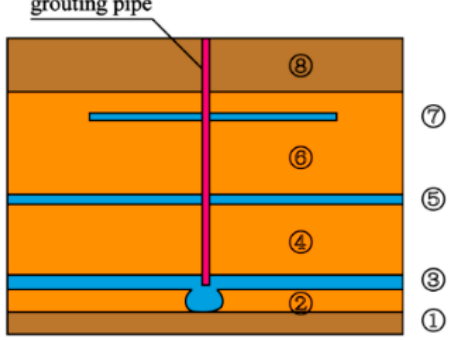
Figure 13. Schematic diagram of injected medium partition.